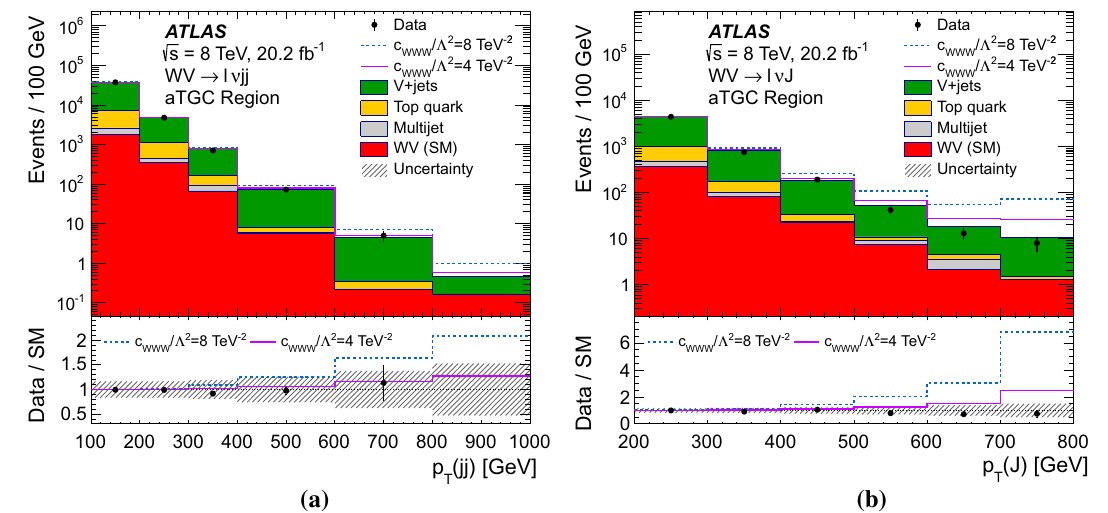
Fig. 7 The observed a p T ( jj ) distribution in the WV → (cid:4)ν jj aTGC signal region, and b p T ( J ) distribution in the WV → (cid:4)ν J aTGC sig- nal region, overlaid with the background and signal prediction. The expected BSM enhancements due to anomalous values of the EFT parameter c WWW /(cid:17) 2 are also shown, for c WWW /(cid:17) 2 = 4 TeV − 2 and Table 5 The observed and expected 95% confidence intervals for the aTGC parameters without the LEP constraint. The confidence intervals are computed separately for the WV → (cid:4)ν jj and WV → (cid:4)ν J chan-